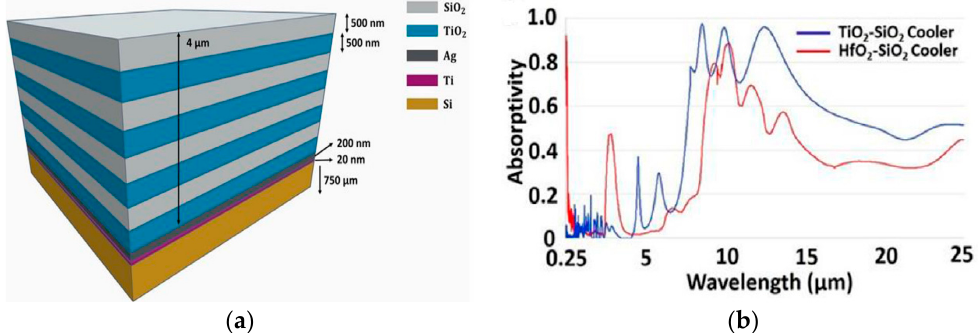
Figure 26. ( a ) A schematic representation of an optimized multi-layered TiO 2 -SiO 2 alternating radiative cooler and ( b ) emission spectrum comparison of an optimized 500 nm TiO 2 -SiO 2 alternating radiative cooler and a HfO 2 -SiO 2 radiative cooler [147].